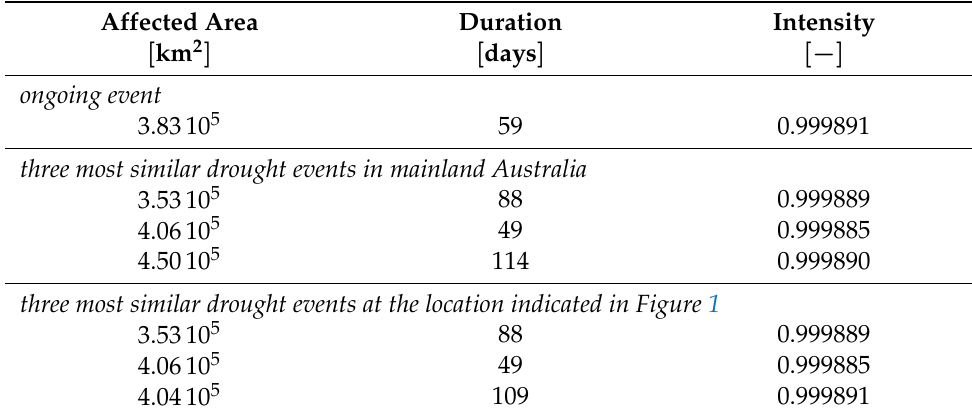
Table 1. Characteristics of drought event at 2 November 2012, experienced at the location indicated in Figure 1 and characteristics of the three most similar drought events in mainland Australia or that include the